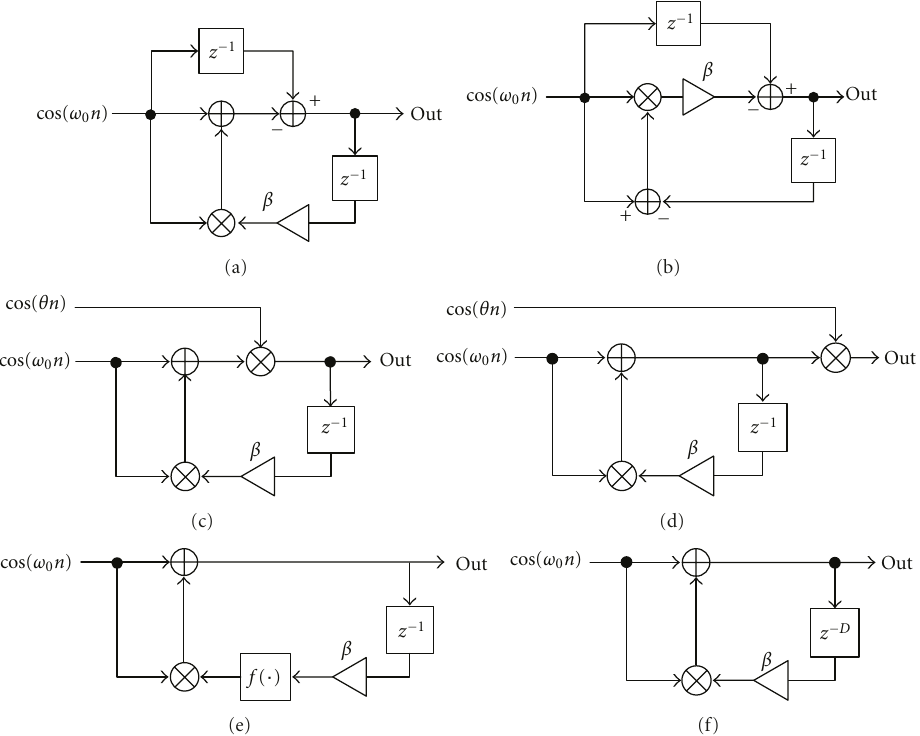
Figure 10: FBAM variation flowcharts. The z − 1 and z − D symbols denote delays of one and D sample periods, respectively.